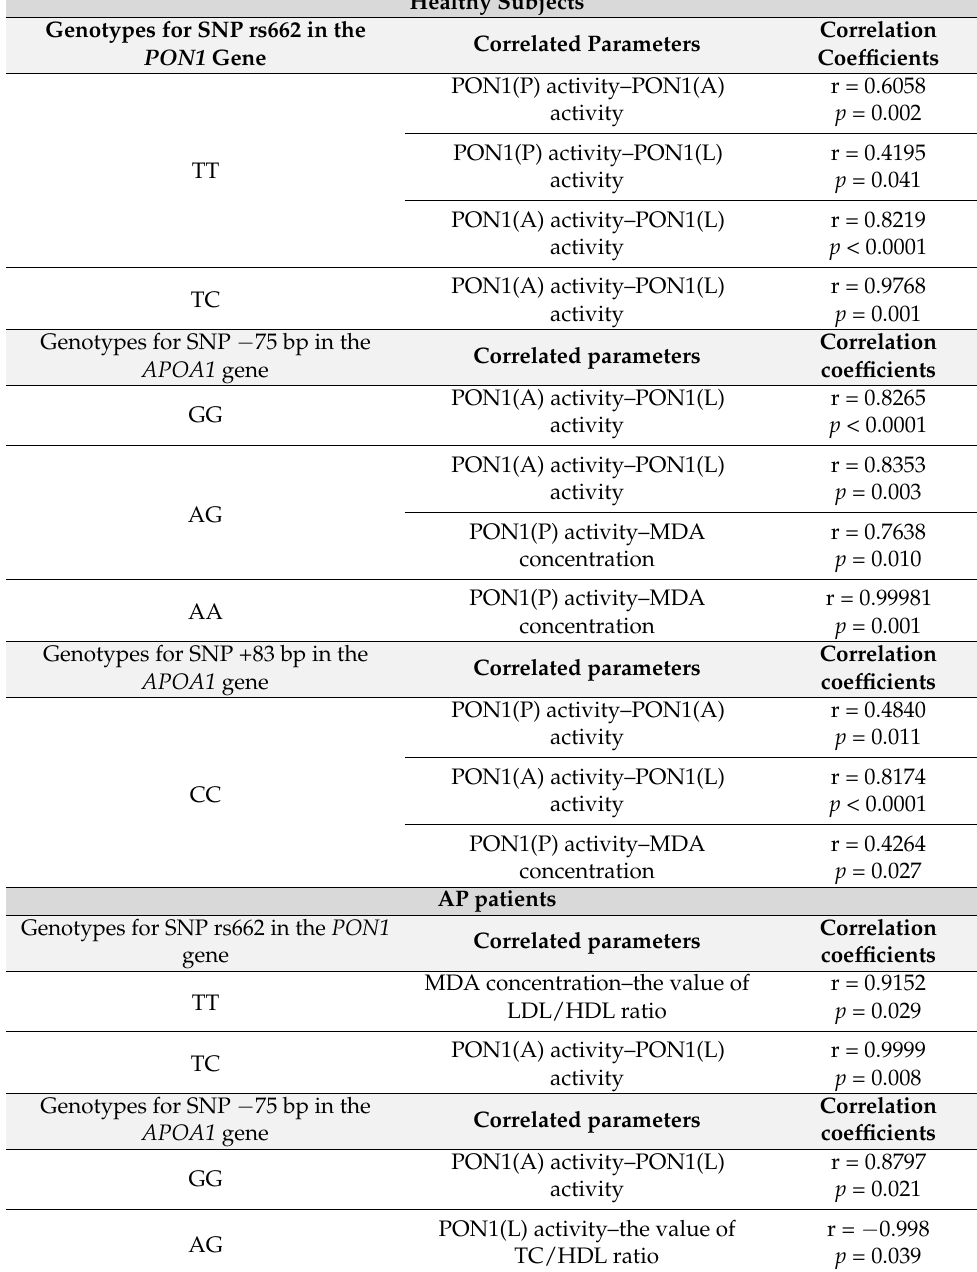
Table 7. Correlation coefficients for the group of healthy subjects and AP